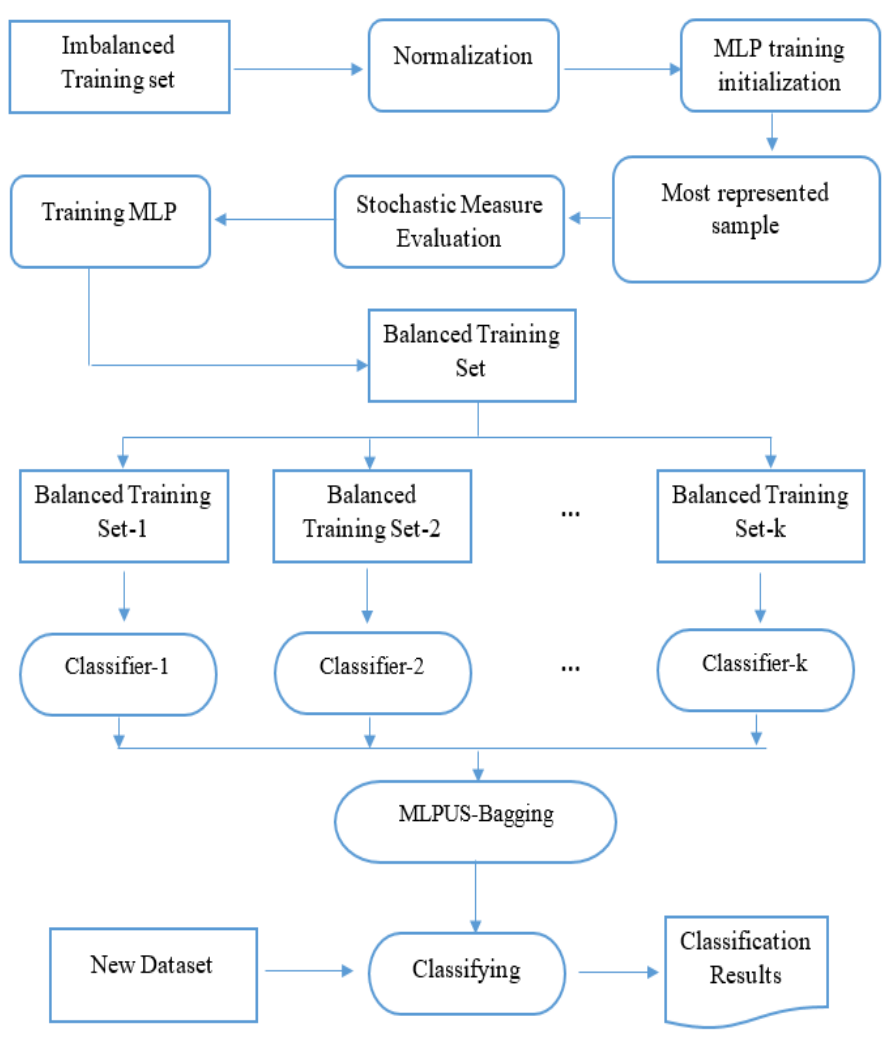
Figure 1. Proposed method Framework.